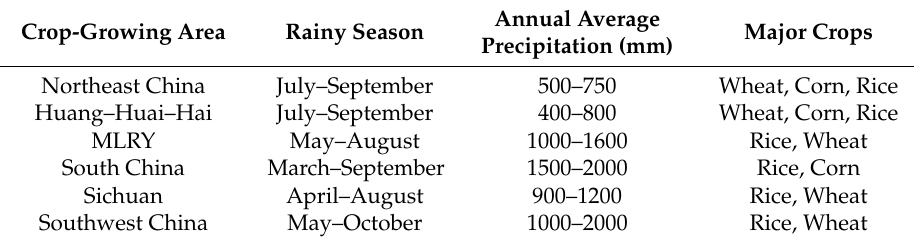
Figure 1. Study areas and meteorological station locations. Table 1. Information on the study areas.